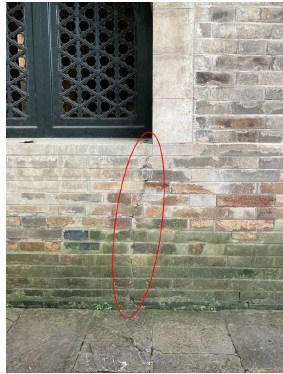
Figure 7. A crack under an opening of the exterior transverse